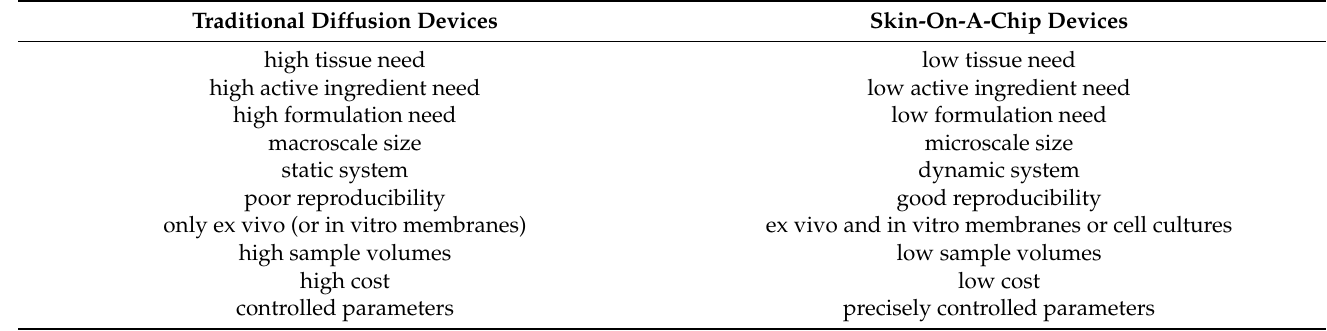
Table 5. Comparison of properties of traditional diffusion cell systems and skin-on-a-chip microfluidic devices. Traditional Diffusion